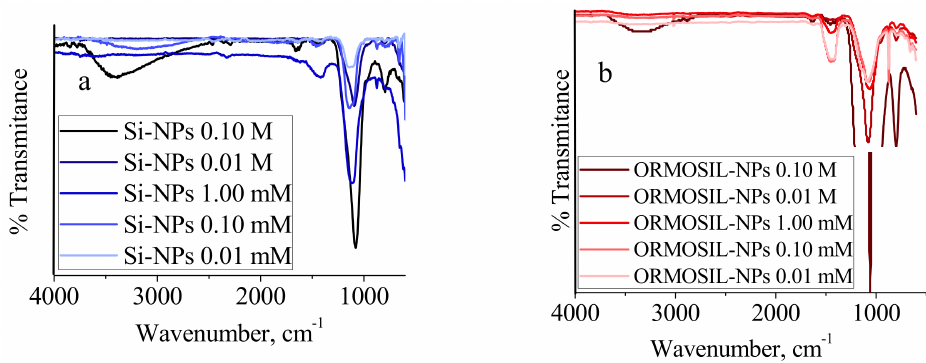
Figure 5. ( a ) FTIR spectra of Si-NPs with decreasing molar concentration of Na 2 SiO 3 as a precursor. ( b ) FTIR spectra of ORMOSIL-NPs with decreasing molar concentration of Na 2 SiO 3 as a